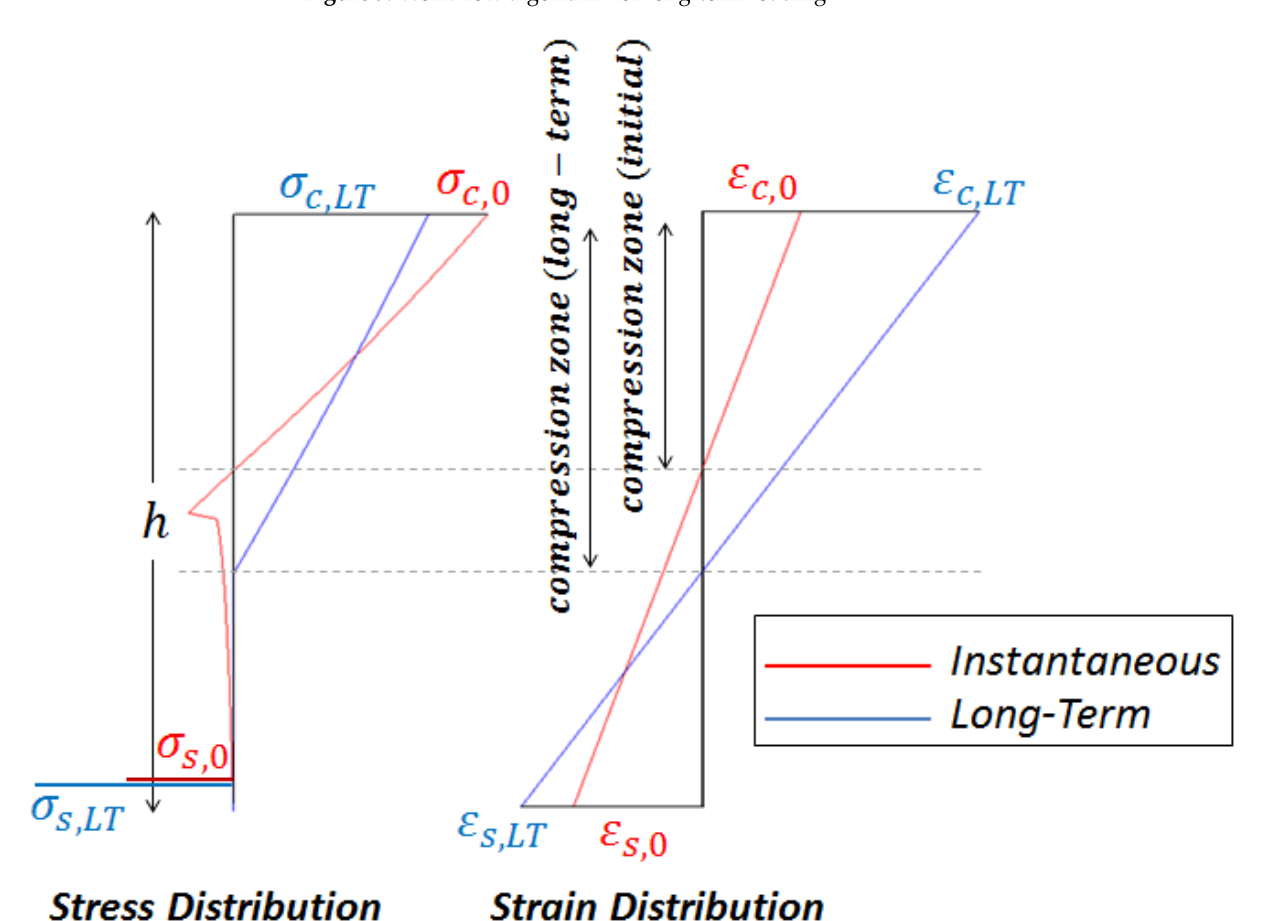
Figure 10. Stress & strain redistribution due to creep.